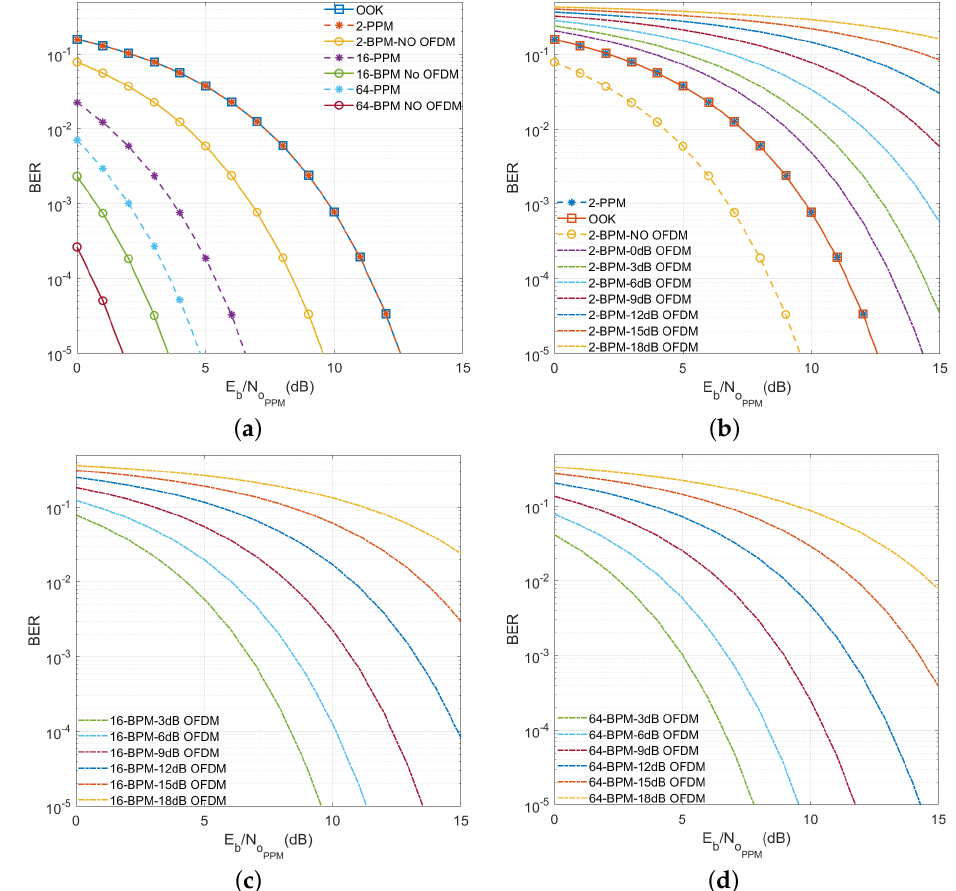
Figure 5. Impact of embedding OFDM within the MCC envelope on BPM BER. ( a ) BPM No-OFDM; ( b ) 2-BPM; ( c ) 16-BPM; ( d )